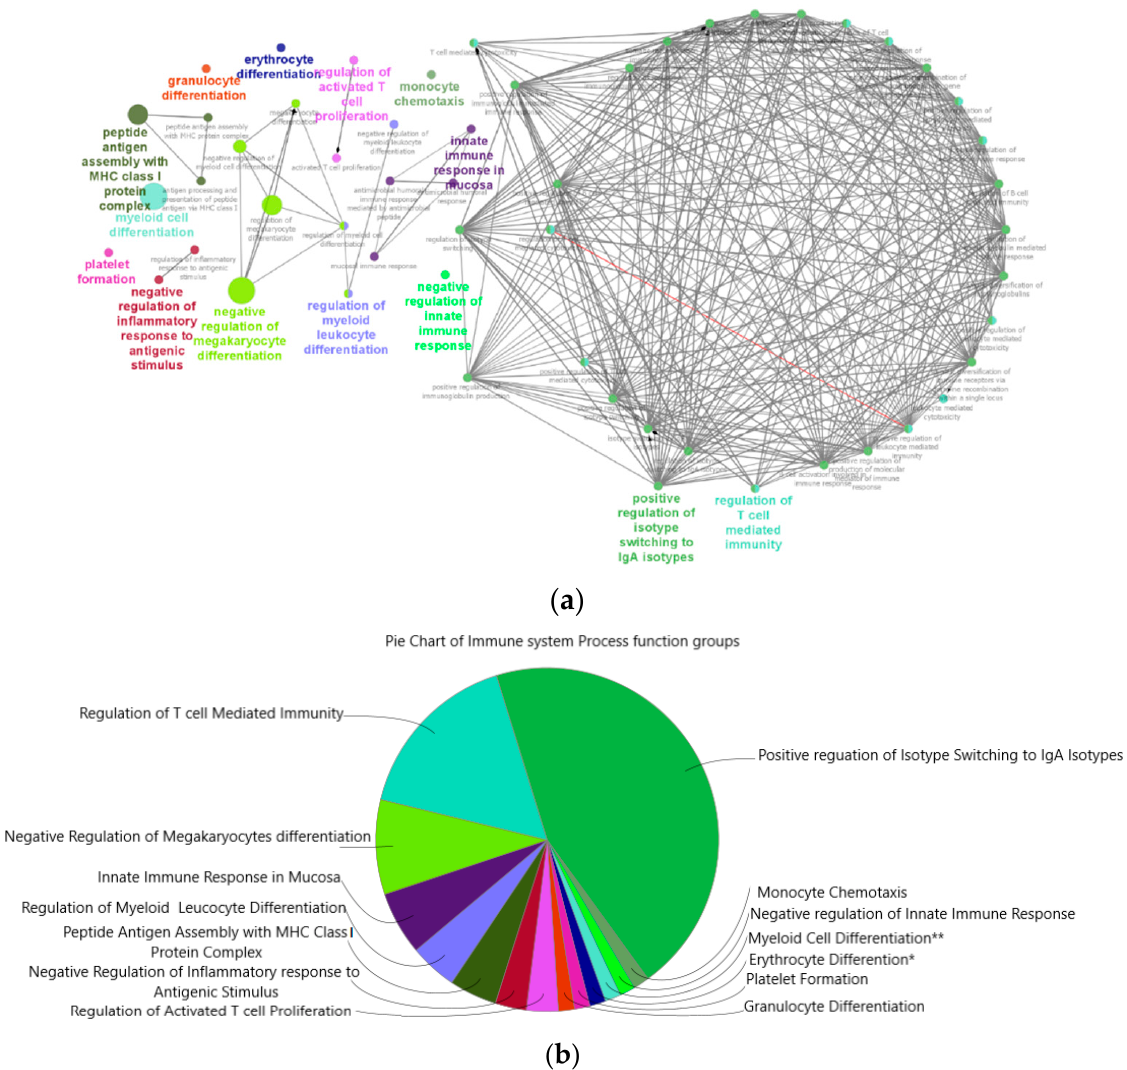
Figure 11. Networks of immune system process of gene ontology (GO) of DEGs in Tg mice. ( a ) Significant differentially expressed genes from RNA-seq analysis of Tg versus WT mice ( n = 8 each) were further analyzed by Cytoscape software with ClueGo to visualize immune system related molecular level interaction networks that were over-represented in Tg mice. The larger the node size, the smaller the GO-terms p value is reflected. Involvement of a number of common genes between the nodes are represented by the degree of the thickness of the lines. Pointed arrowhead indicates activation/positively regulation. Diamond arrowhead indicates regulation. Immune system process of GO-terms for each group is labelled in colored bold letters. ( b ) A pie chart of immune system process GO-terms pathway network groups. A total of fourteen functional immune system process GO-terms groups were involved more prominently in Tg mice compared to WT mice. Significant networks of the immune system (group p value corrected with Bonferroni step down) were indicated by asterisk (** for p < 0.01 and * for p < 0.05).